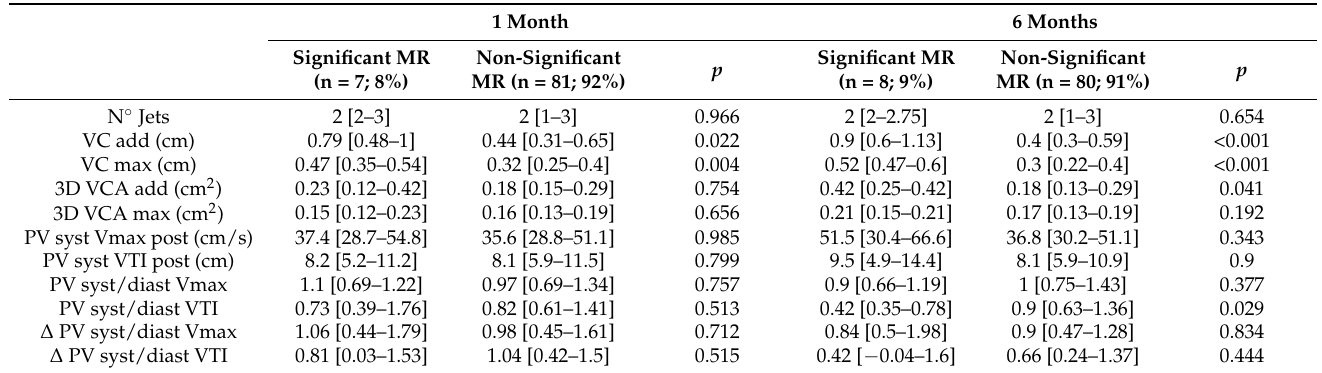
Table 3. Differences in intraprocedural TEE quantitative parameters in relation with significant MR in follow-up TTE.